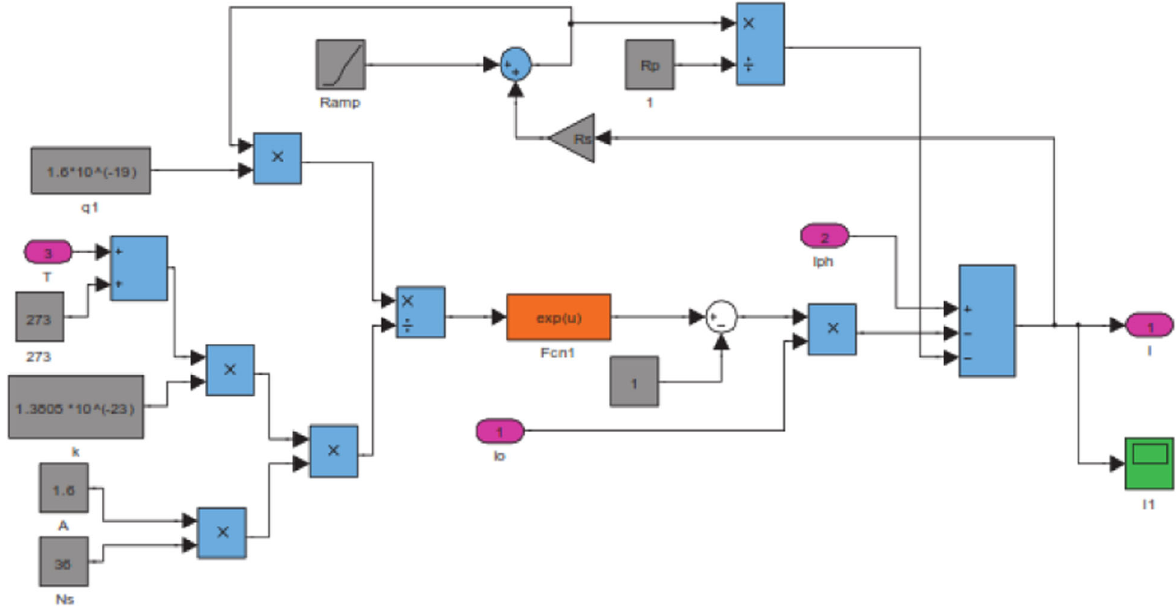
Fig. 4 PV model considering R p